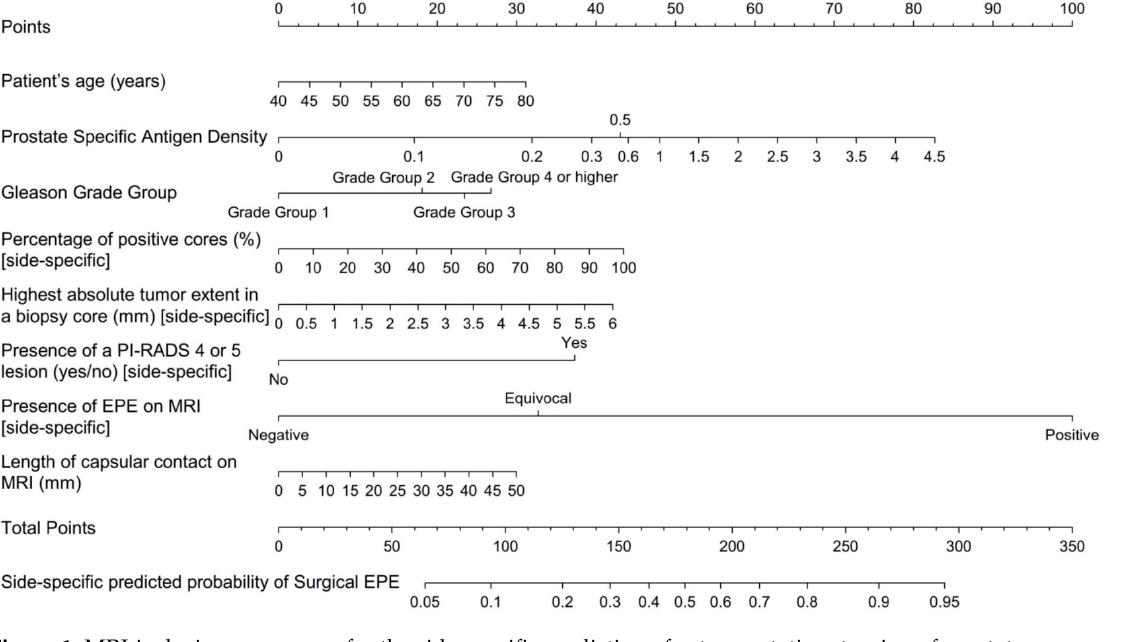
Figure 1. MRI-inclusive nomogram for the side-specific prediction of extraprostatic extension of prostate cancer. Table 3. Performance statistics of the MRI-inclusive nomogram and the benchmark